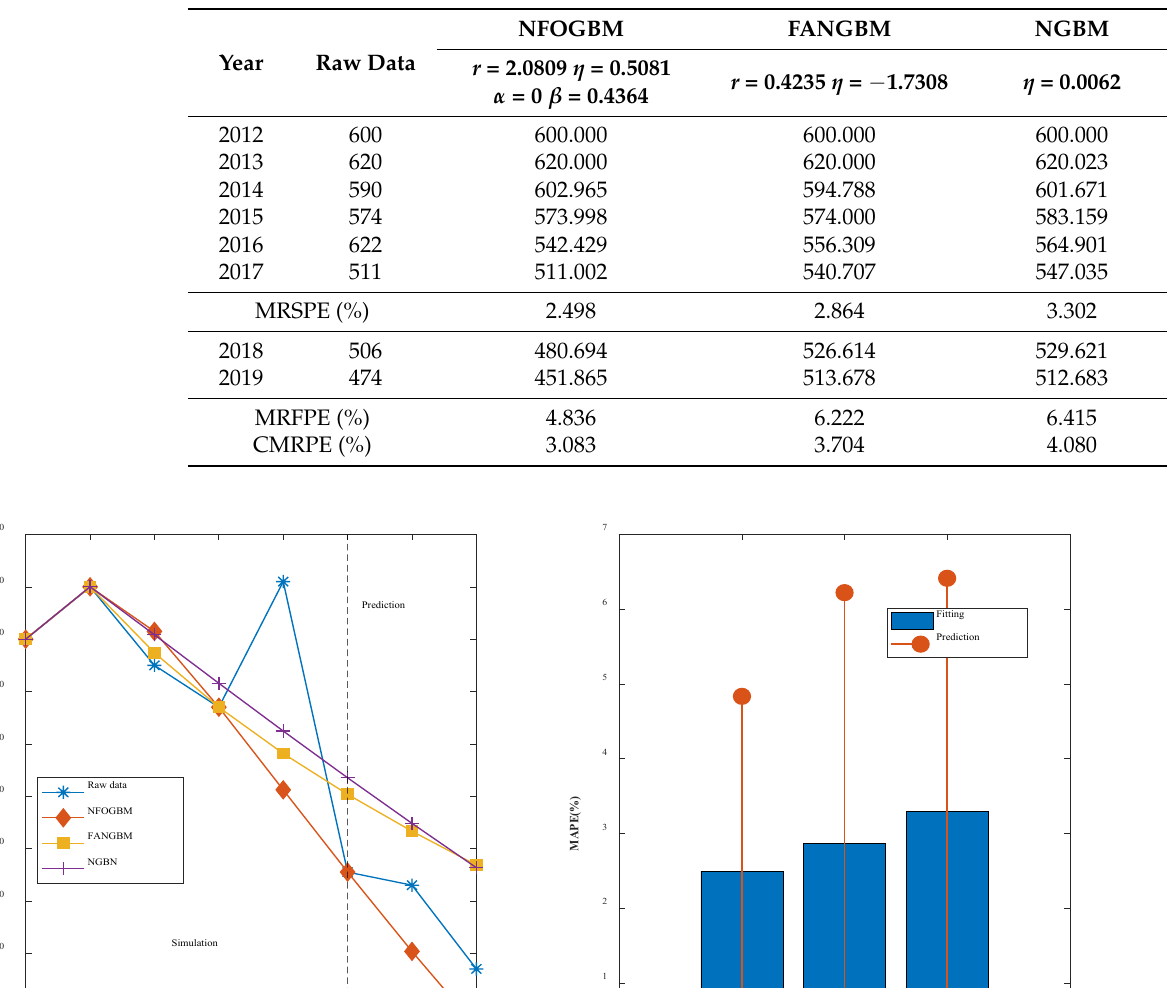
Table 3. Modeling results for PNGE.